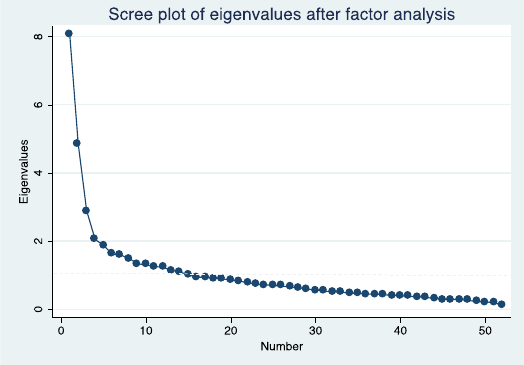
Figure 1. Scree plot for first-factor analysis. Table 2. First-order exploratory factor analysis.